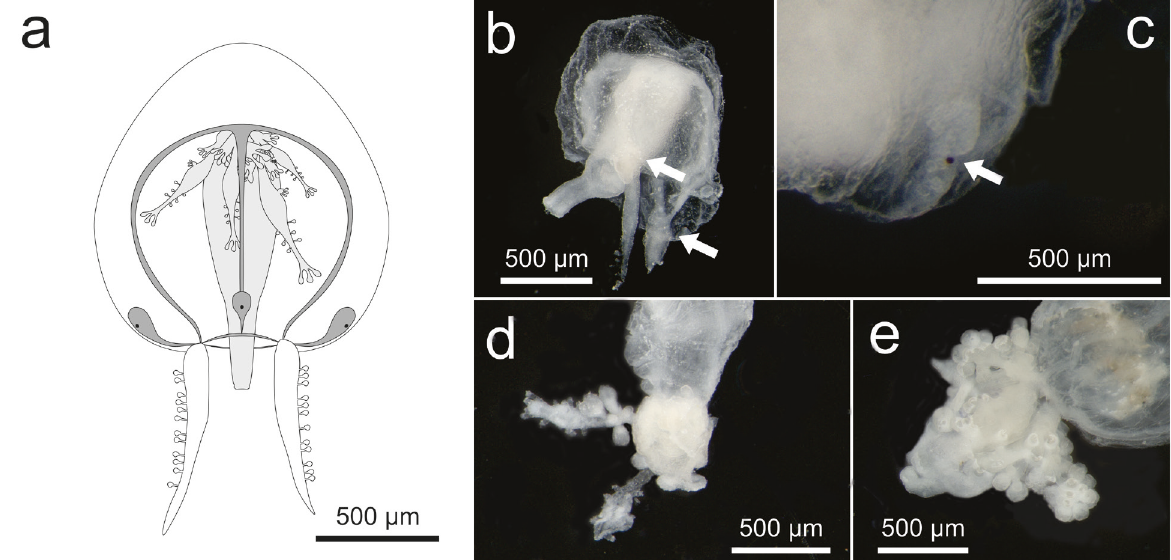
Figure 1. Teissiera polypofera from Western Atlantic Ocean. (a) Schematic representation of full specimen. b) full view (arrows indicating tentacle bulbs). (c) detail on exumbrellar cnidocyst pouch with red-brown ocelli (indicated by the arrow). (d and e) detail on manubrium and several polyp buds and medusoid buds in